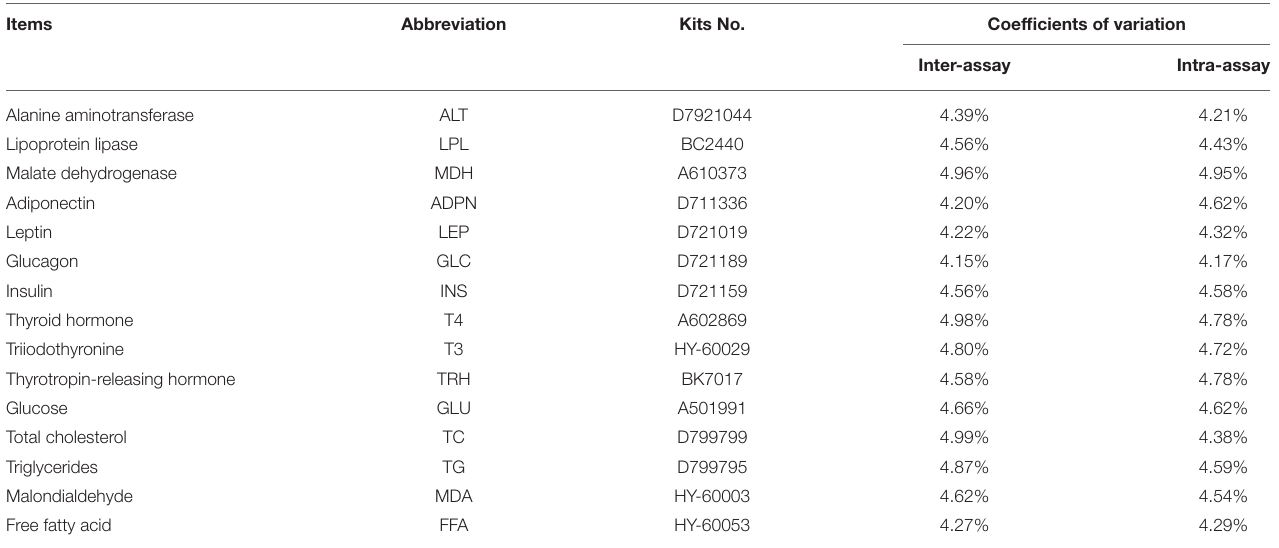
TABLE 3 | The kits information of serum biochemical